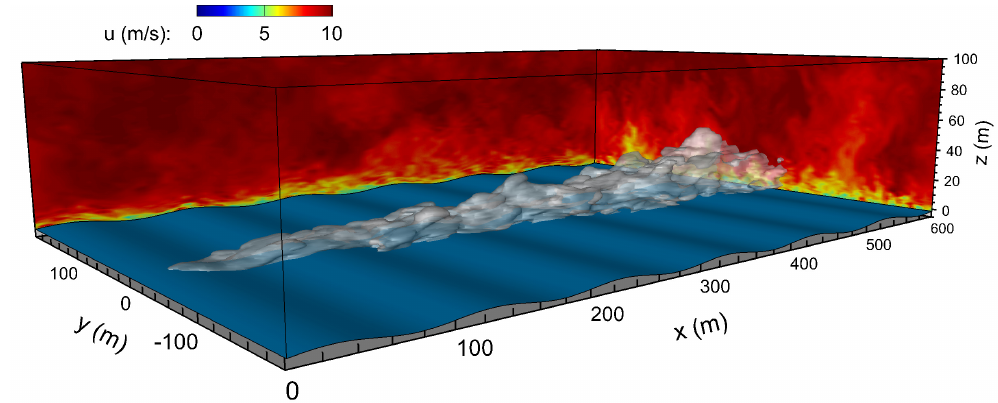
Figure 2. Illustration of three-dimensional instantaneous flow and aerosol fields for wind over swell waves. Contours of the instantaneous streamwise velocity u are shown on the two vertical planes. The oil aerosol field for d = 2.5 µ m is visualized by the isosurface of oil droplet concentration C d = 1 × 10 − 4 g/m 3